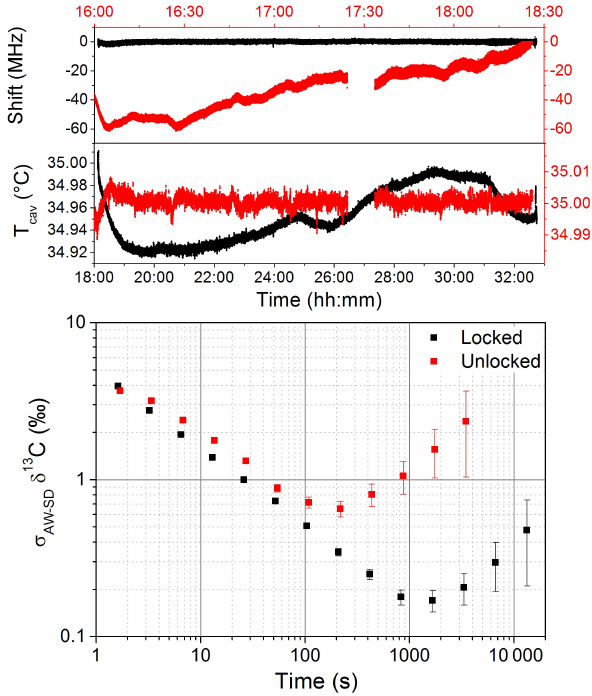
Figure 3. A comparison of the performance on the measurement of the δ 13 C-CH 4 with (black) and without (red) the lock of the po- sition of the cavity modes. Without the locking the temperature is stabilized at 35 ± 0 . 0015 ◦ C and the mode position drifts by about 20MHzh − 1 . By locking the mode positions acting on the temper- ature set point, the mode positions are stabilized to 620kHz. The advantage of the locking configuration is visible in the log–log plot, where the AW standard deviation of the δ 13 C-CH 4 signal is shifted to slightly lower values, with a longer averaging-time stability. Both measurements were performed by continuously flushing the cavity with a 10sccm gas flow of a synthetic air mixture containing 72 and 20ppmv of CH 4 and C 2 H 6 in dry air,